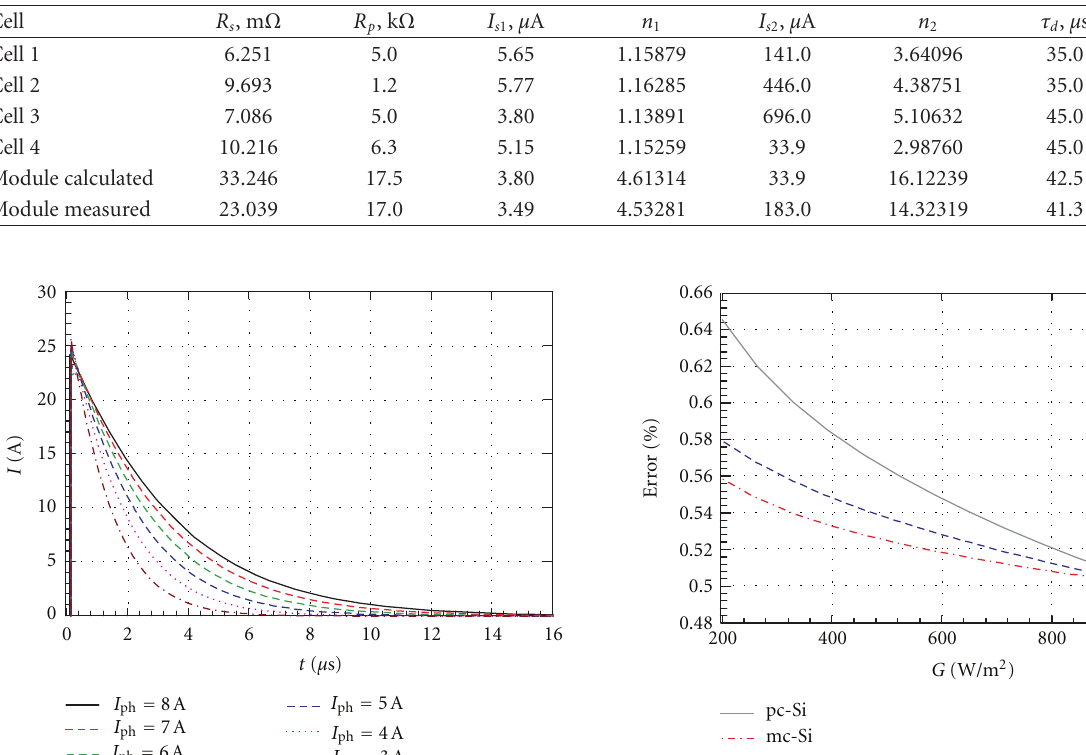
Table 4: Extracted parameters of individual cells and module (monocrystalline silicon solar cells).